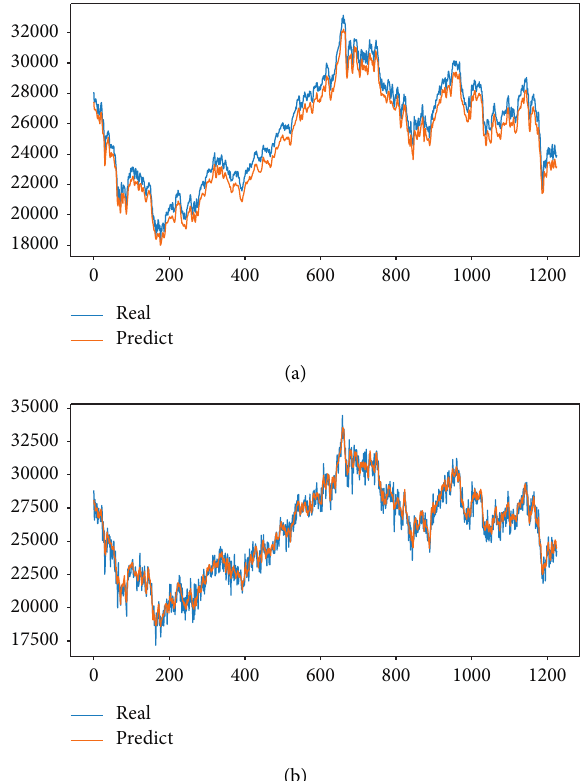
Figure 12: Prediction results of (a) LSTM-EMD method and (b) LSTM-EEMD method of HSI time